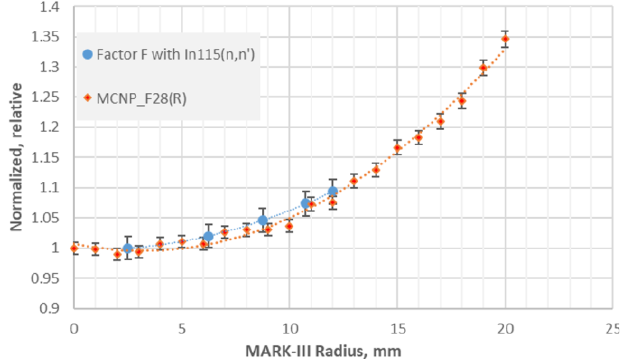
Fig. 4. Radial gradient in the MARK-III convertor (at axial position H = 0 cm) obtained with irradiation of In 115 [3] and F28(R) calculated with MCNP. The results of Meff 238 of CFUL01 measured in the MARK- III fast neutron flux using (1) and multiplied by K Meff-238H,R are shown in Table III. The uncertainties of the results are ±2.9 % and they are propagated as discussed for this method in [6] and include the uncertainty on K Meff-238H,R